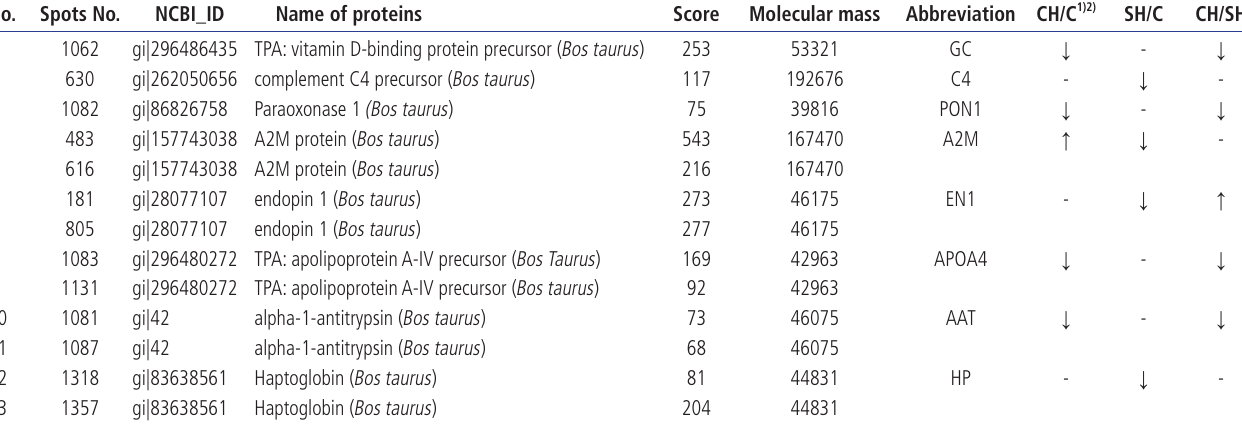
Table 2. Identification of 16 differentially expressed proteins expressed among the three groups by mass spectrometry No. Spots No.